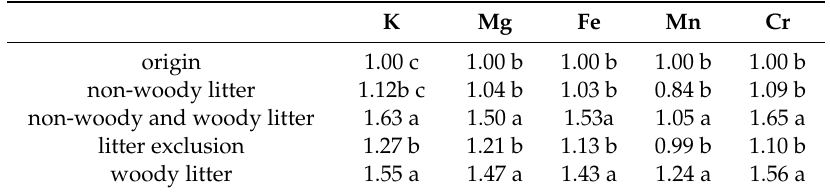
Figure 4. Export ratios of the metals (K, Mg, Fe, Mn, Cr) from the origin stream compared to those from the treatment stream (4 input conditions). The lines are the k -value trend lines of the treatment / origin streams, and the blue dotted line is the trend line with k -value of 1. Table 5. Export ratios of the metals from the origin stream compared to the treatment stream with 4 litter input